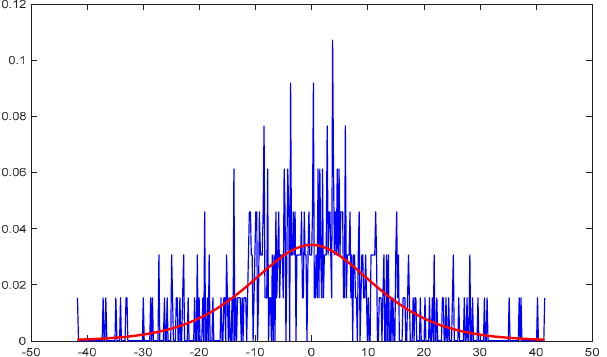
Figure 6. The corresponding normal inverse Gaussian of probability density functions (NIG pdfs) constructed from the estimated α and δ (in red).